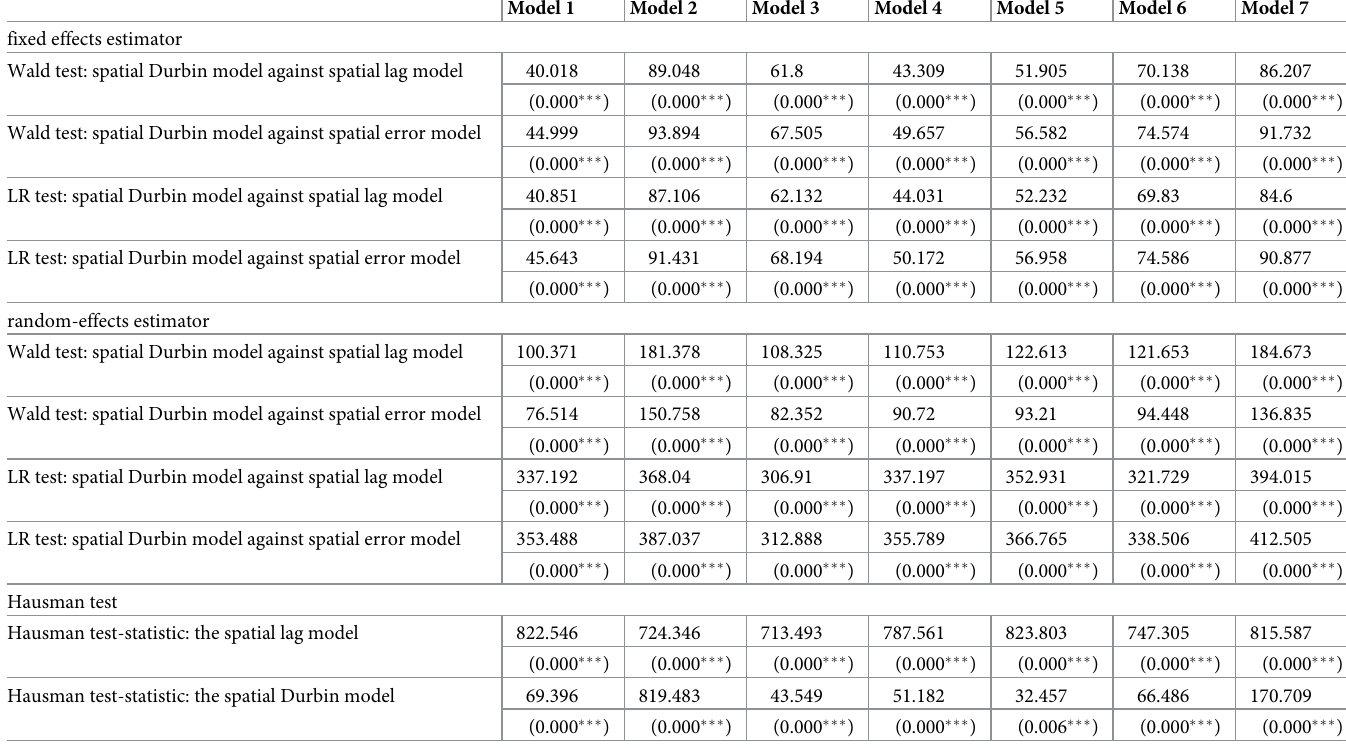
Table 3. The spatial Durbin model and Hausman test